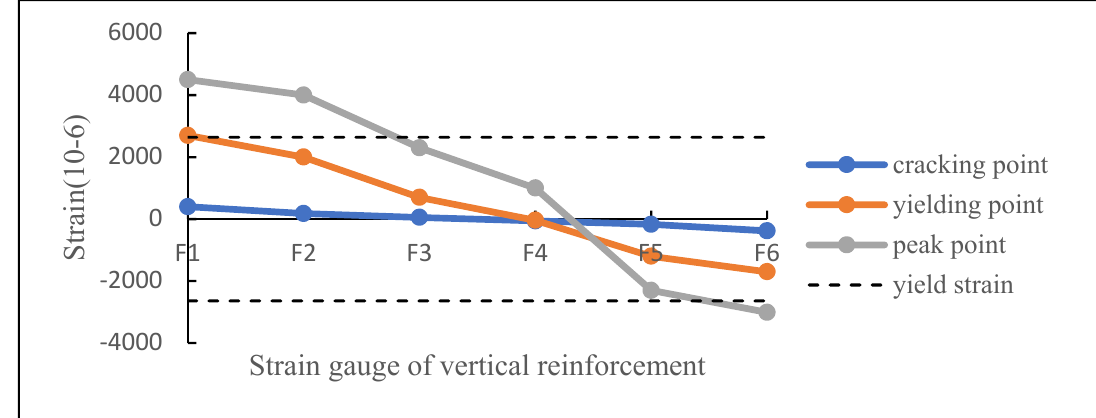
11 of 14 Figure 12. Calculation of equivalent viscous damping. Figure 13. Equivalent viscous damping coefficient of viscous damping.